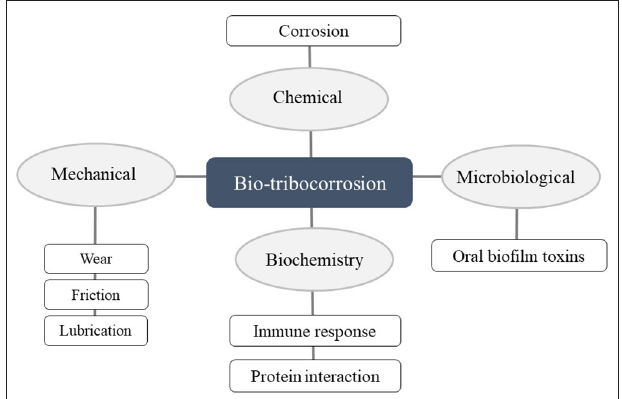
FIGURE 1 | Primary concept and definition of